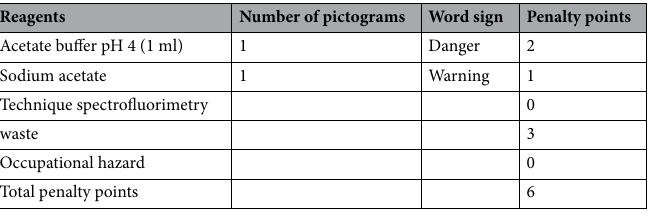
Table 7. Results for evaluation of greenness of the proposed approaches by the Analytical Eco-Scale score.